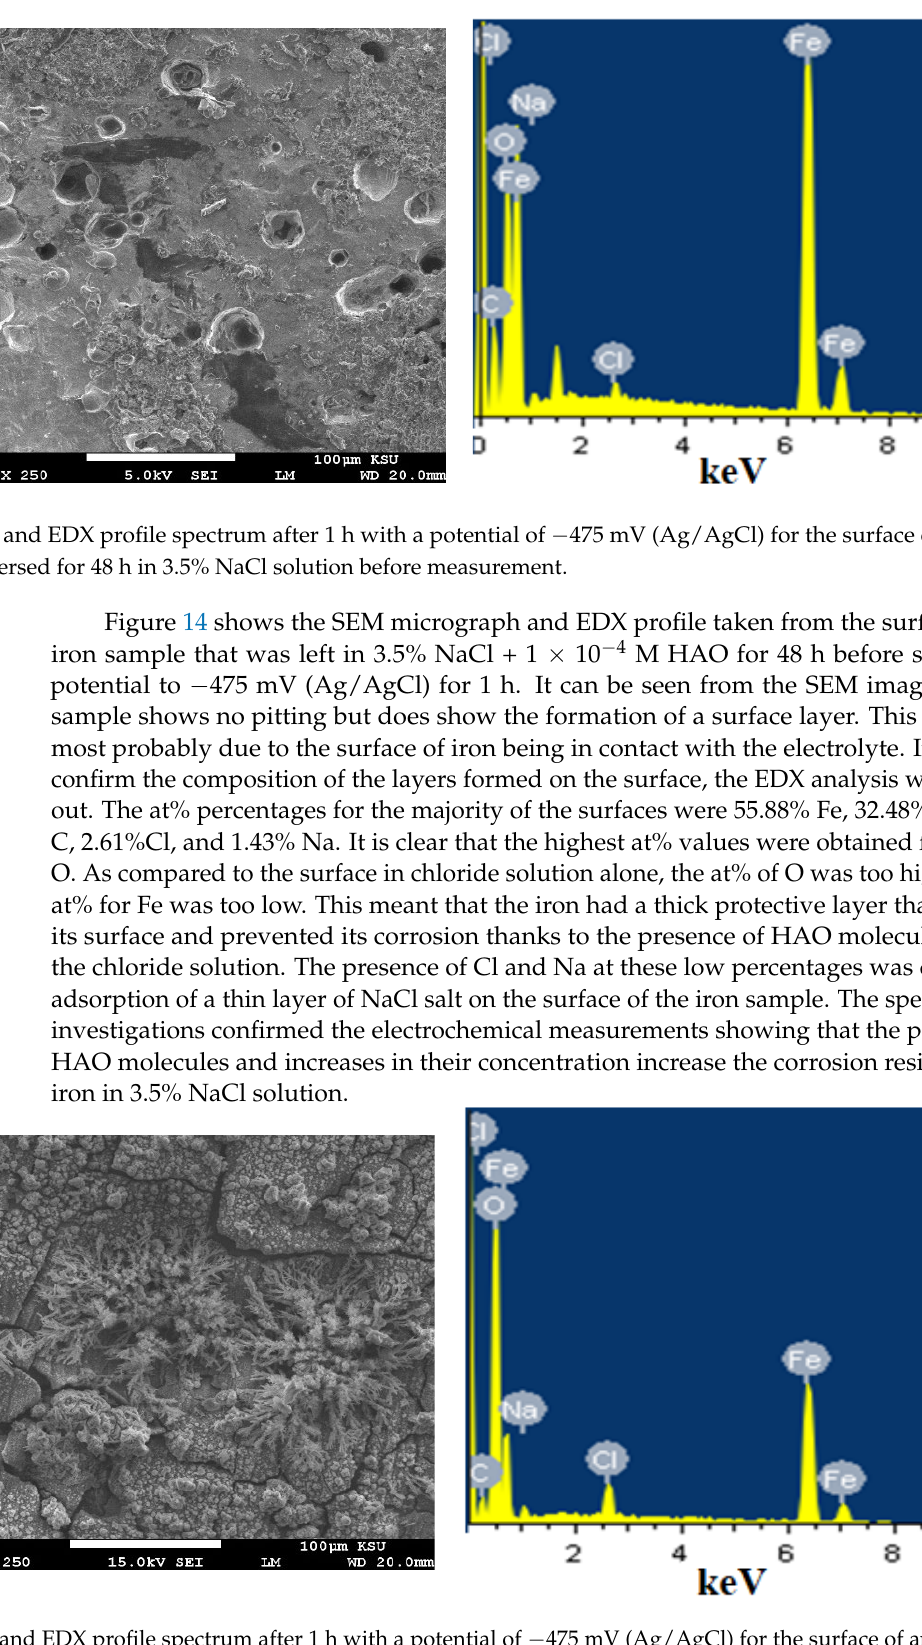
Figure 14. SEM image and EDX profile spectrum after 1 h with a potential of − 475 mV (Ag/AgCl) for the surface of an iron sample that was immersed for 48 h in 3.5% NaCl solution containing 1 × 10 −4 M HAO before measurement.